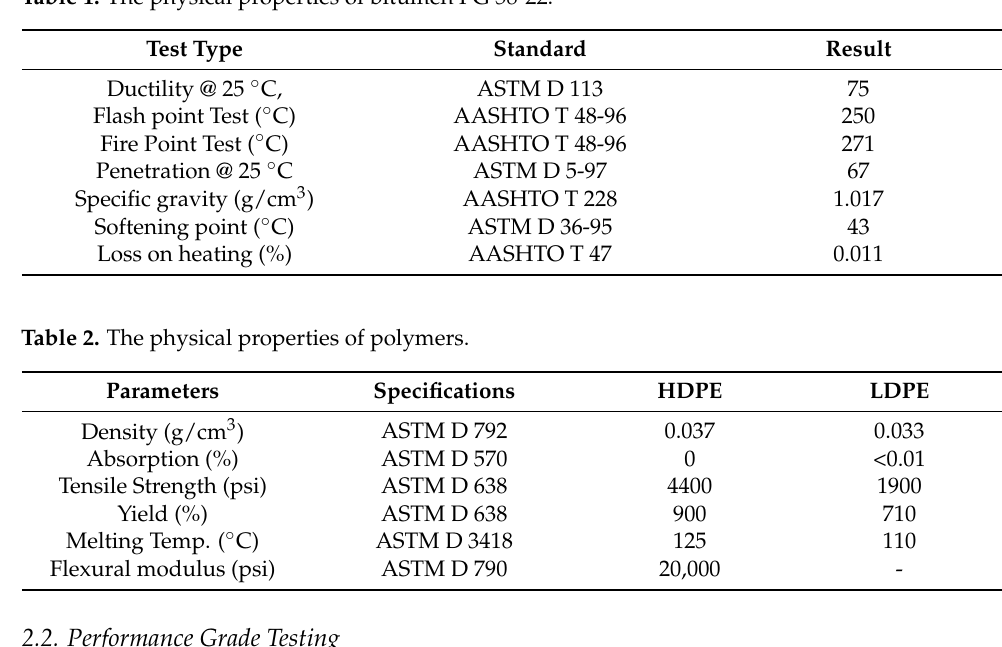
Table 1. The physical properties of bitumen PG 58-22.